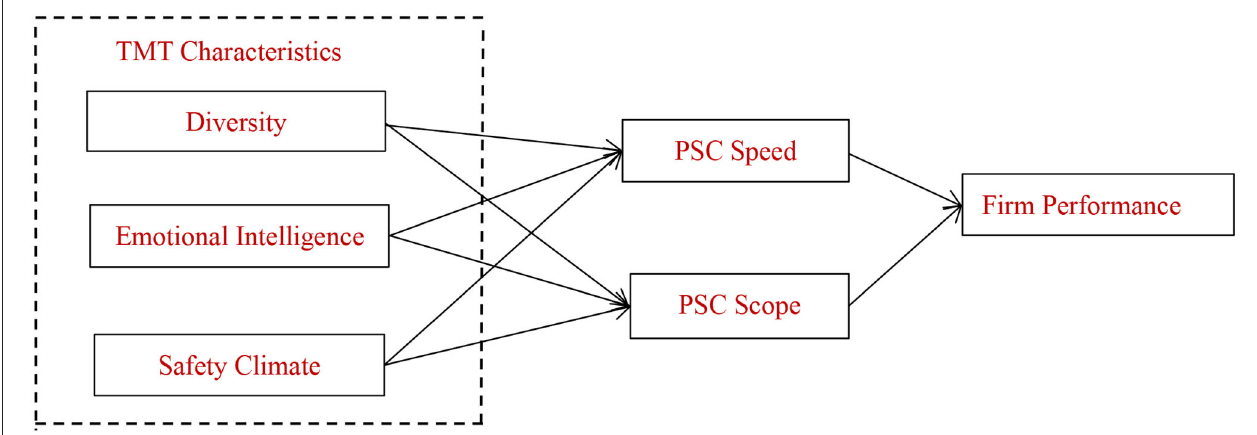
FIGURE 1 | Conceptual model. TMT, top management team; PSC, patent strategic